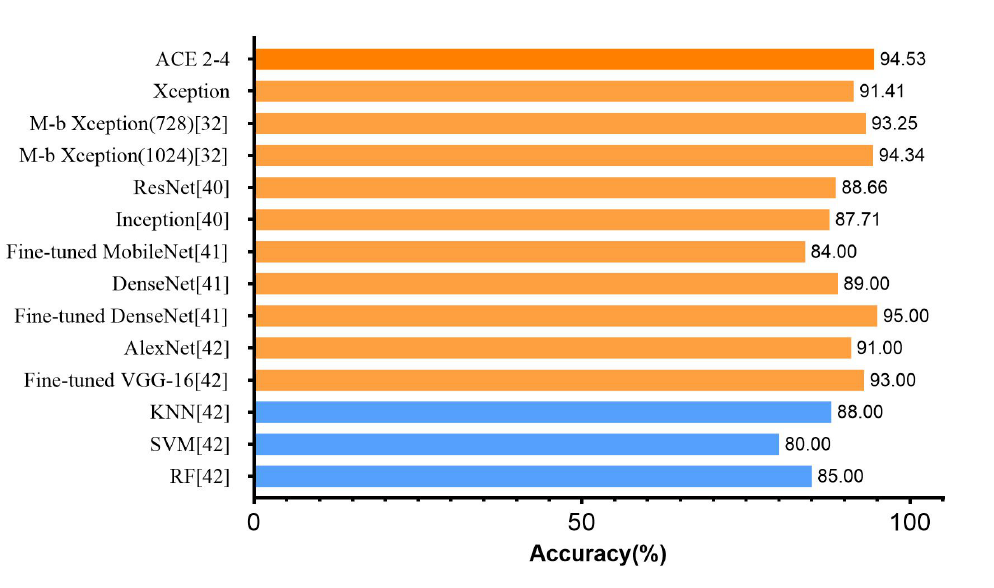
Figure 8. The statistical histogram graph of the comparison between the proposed “ABE 2-4” model and relatively new technologies in recent